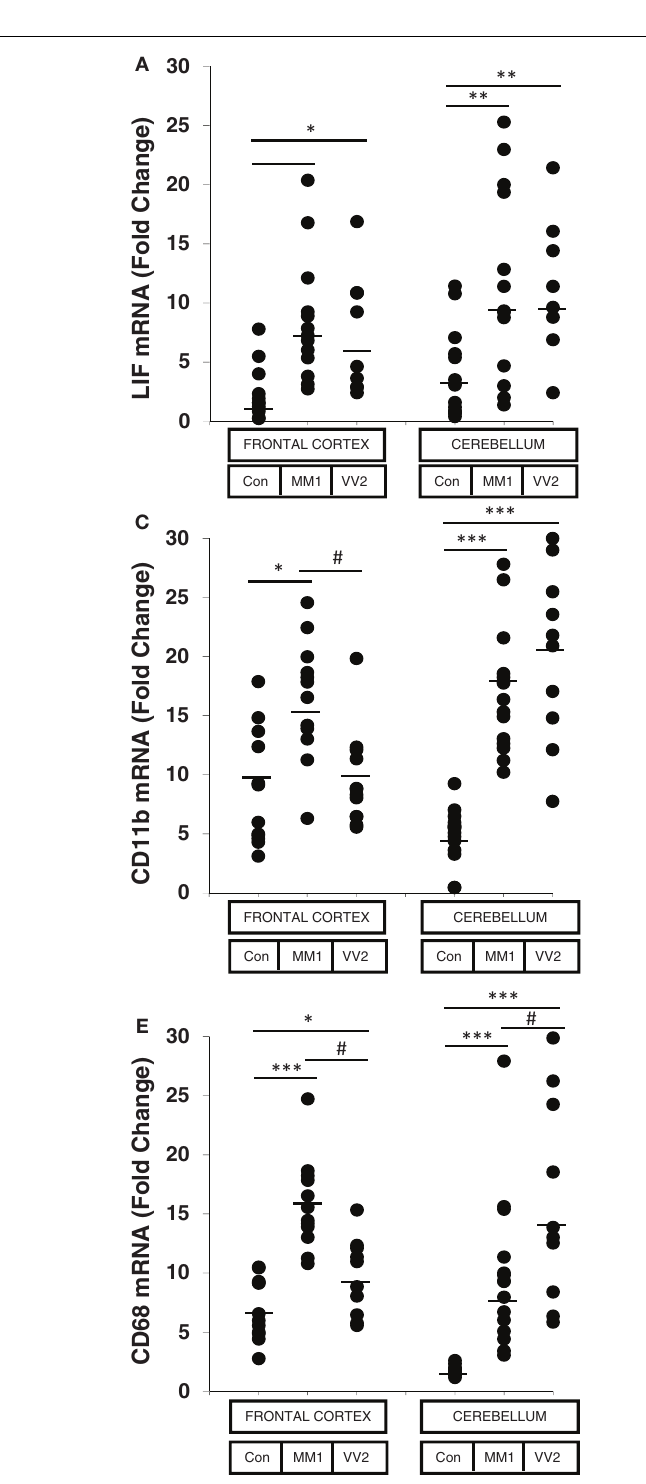
FIGURE 1 | mRNA expression analysis of glial activators and markers in sCJD is shown . RT-qPCR analysis of glial activators and markers in the frontal cortex and cerebellum of control and sCJD MM1 andVV2 subtypes: (A) LIF, (B) GFAP, (C) CD11b, (D) IBA1, (E) CD68, and (F) OLIG2. Values are normalized using GUS-b and GAPDH as internal controls.